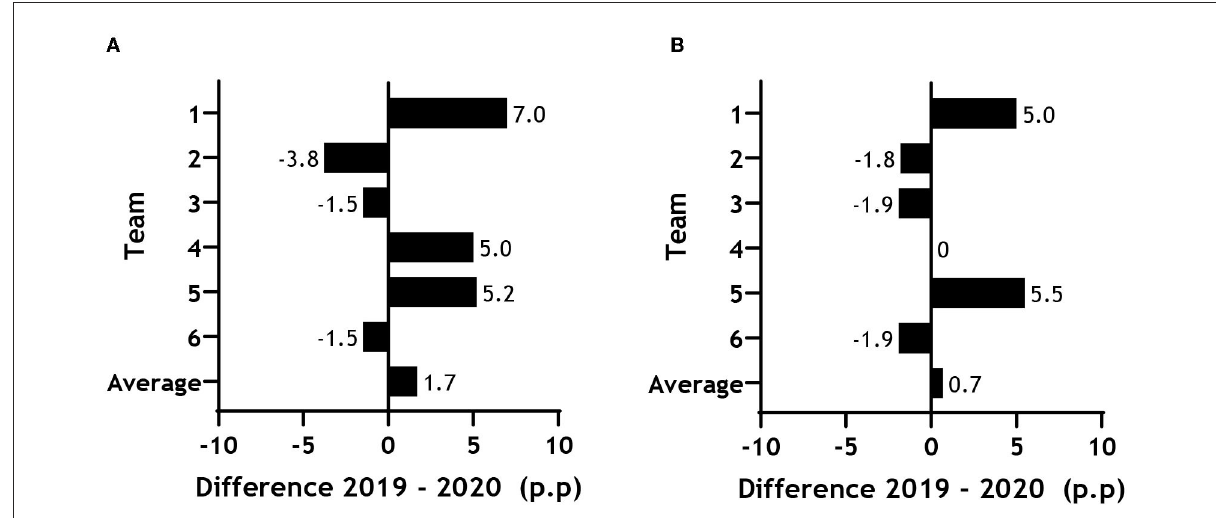
FIGURE5 Training (A) and match (B) availability for all teams on average. Presented as percentage points difference from 2019 to 2020.